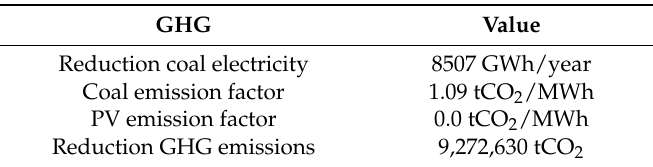
Table 6. Reduction of GHG emissions for 10% greenhouse area covered by PV modules ([52], Authors’). GHG: greenhouse